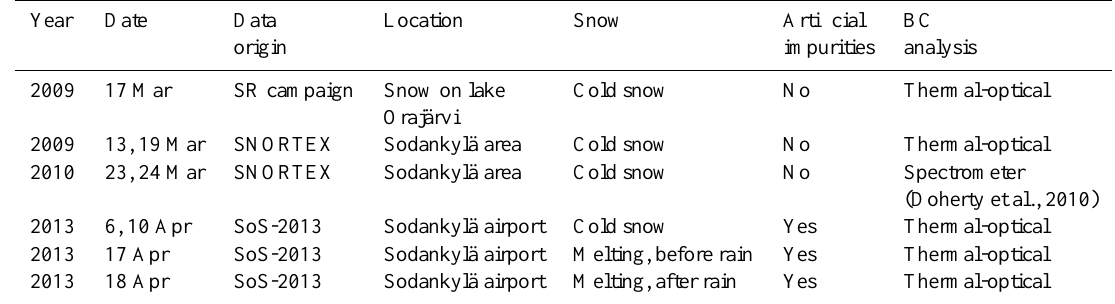
Table 1. The origin of our Sodankylä snow density data coupled with BC analysis results. The campaigns are explained in the text. Year Date Data Location